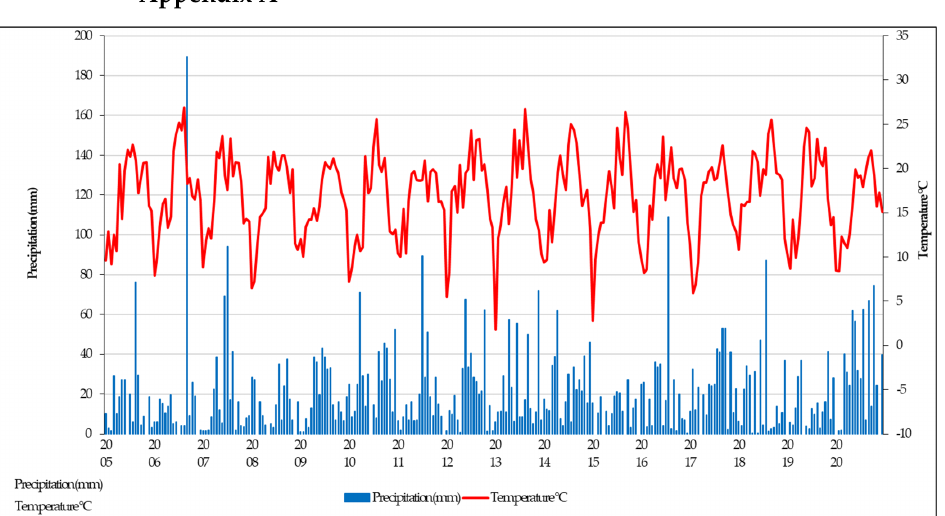
Figure A1. Rainfall and average air temperatures between January 2005 and December 2020, ARS D ł o ń , Poland.